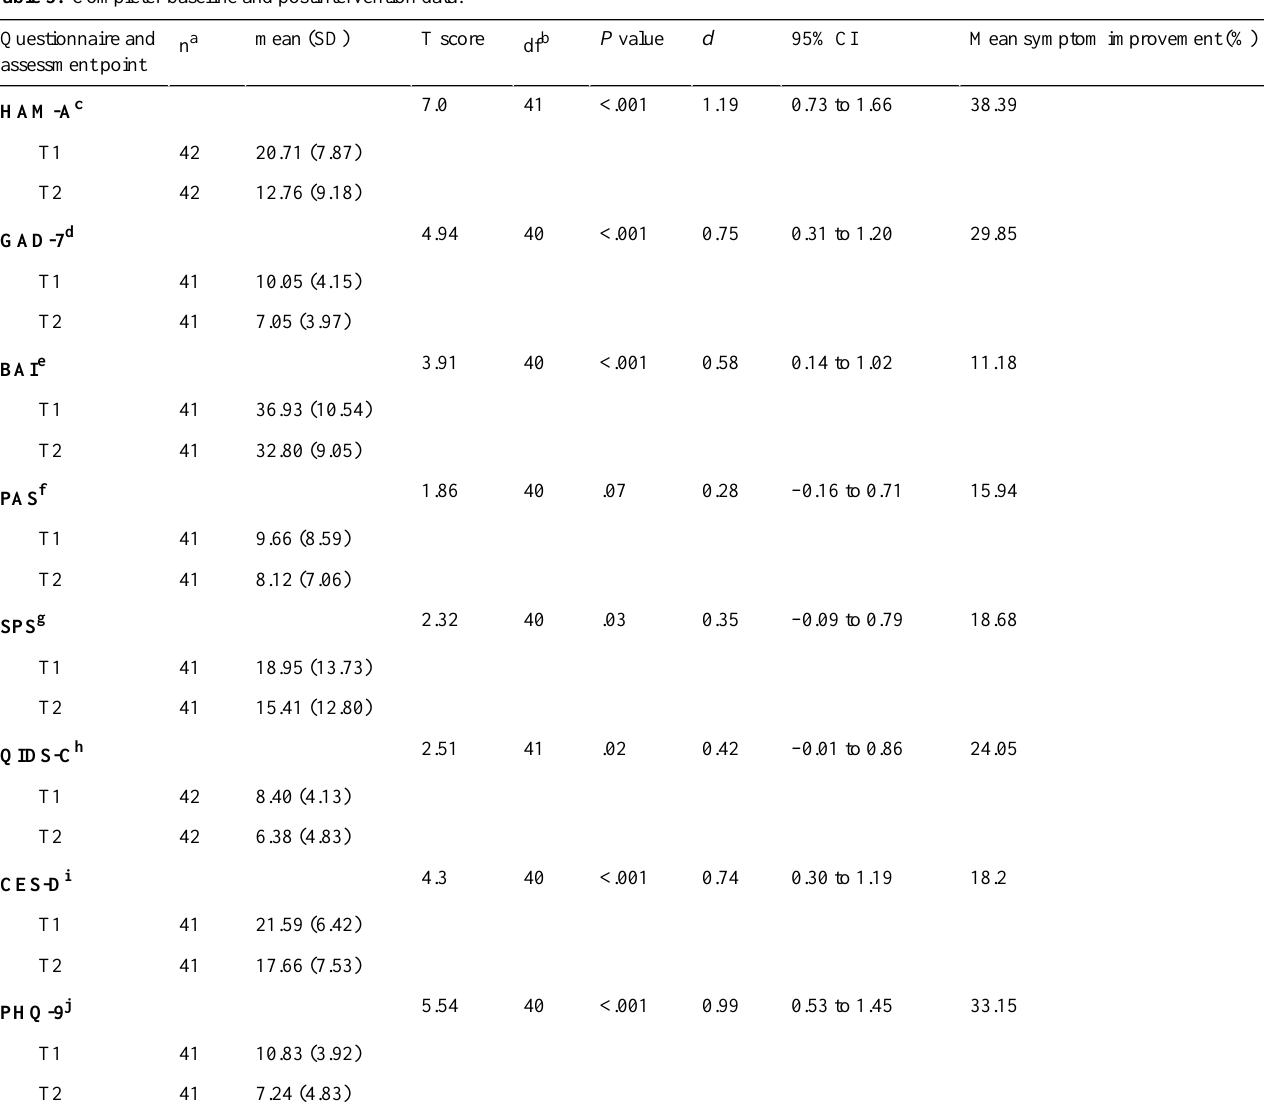
Table 3. Completer baseline and postintervention